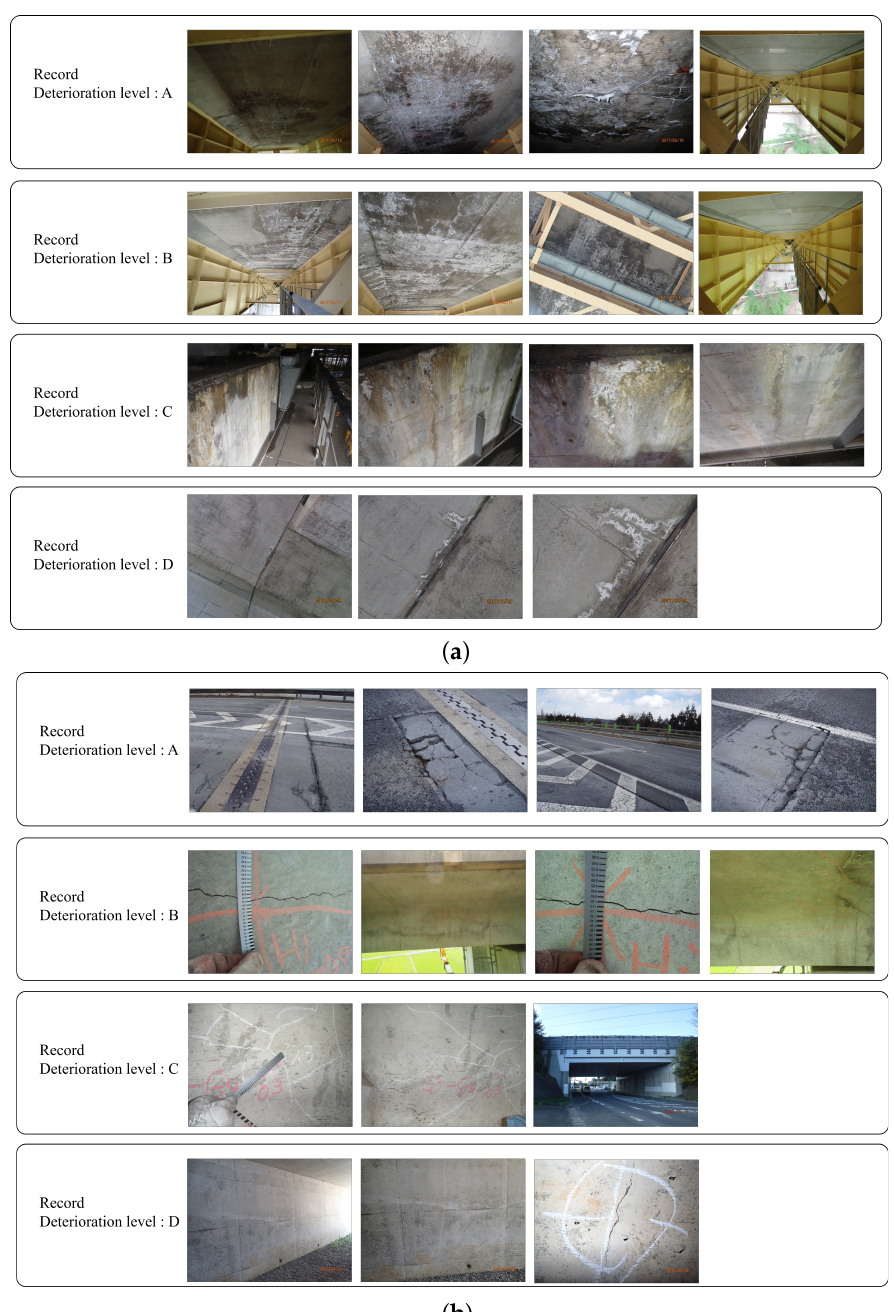
Figure 4. The examples of distress images in records. ( a ) Efflorescence and ( b )